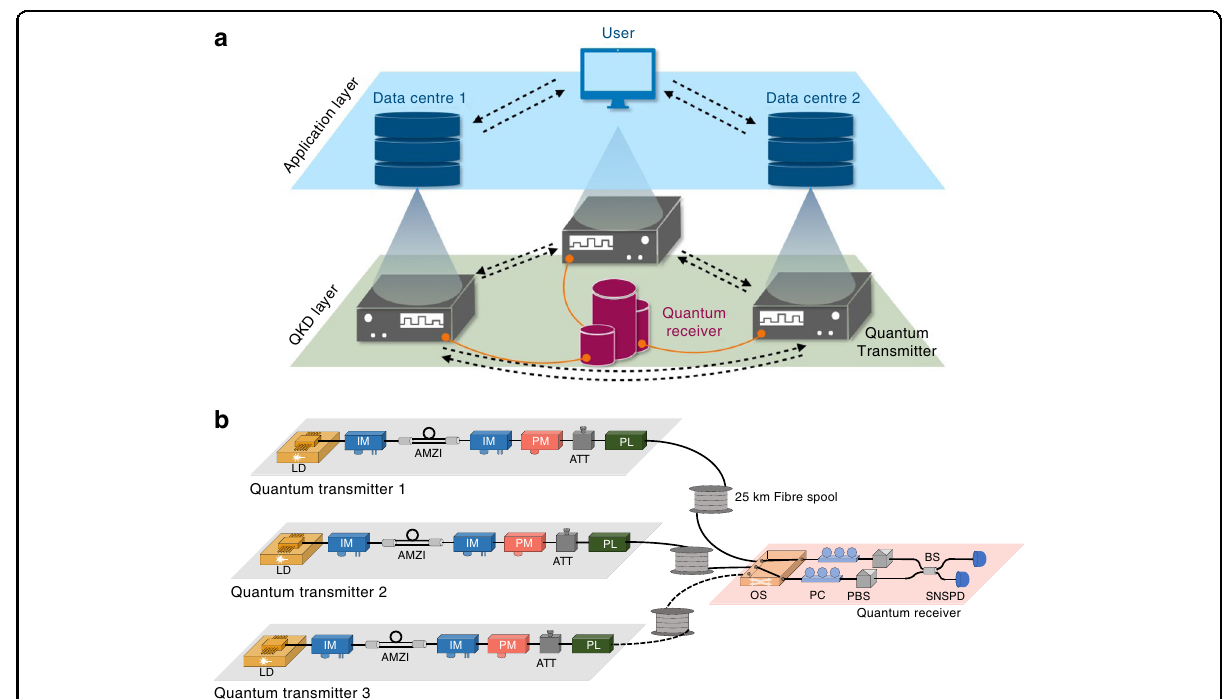
Fig. 2 Schematic of our proposed SPIR system. a The SPIR system comprises two layers, the QKD layer and the application layer, which operate independently except for the transfer of secret keys. In the QKD layer, quantum transmitters are paired for key distribution, which includes procedures of quantum state preparation, quantum state measurement, and classical post-processing. In the application layer, each party obtains and manages the generated secret keys for the implementation of the SPIR protocol. The black dashed arrows represent the direction of the classical communication, while the orange solid lines represent quantum channels for QKD. b Schematic of the MDI QKD implementation. LD laser diode, IM intensity modulator, PM phase modulator, BS beam splitter, AMZI asymmetric Mach – Zehnder interferometer, ATT optical attenuator, PL optical power limiter, OS Optical switch, PC polarisation controller, PBS polarising beam splitter, SNSPD superconducting nanowire single-photon